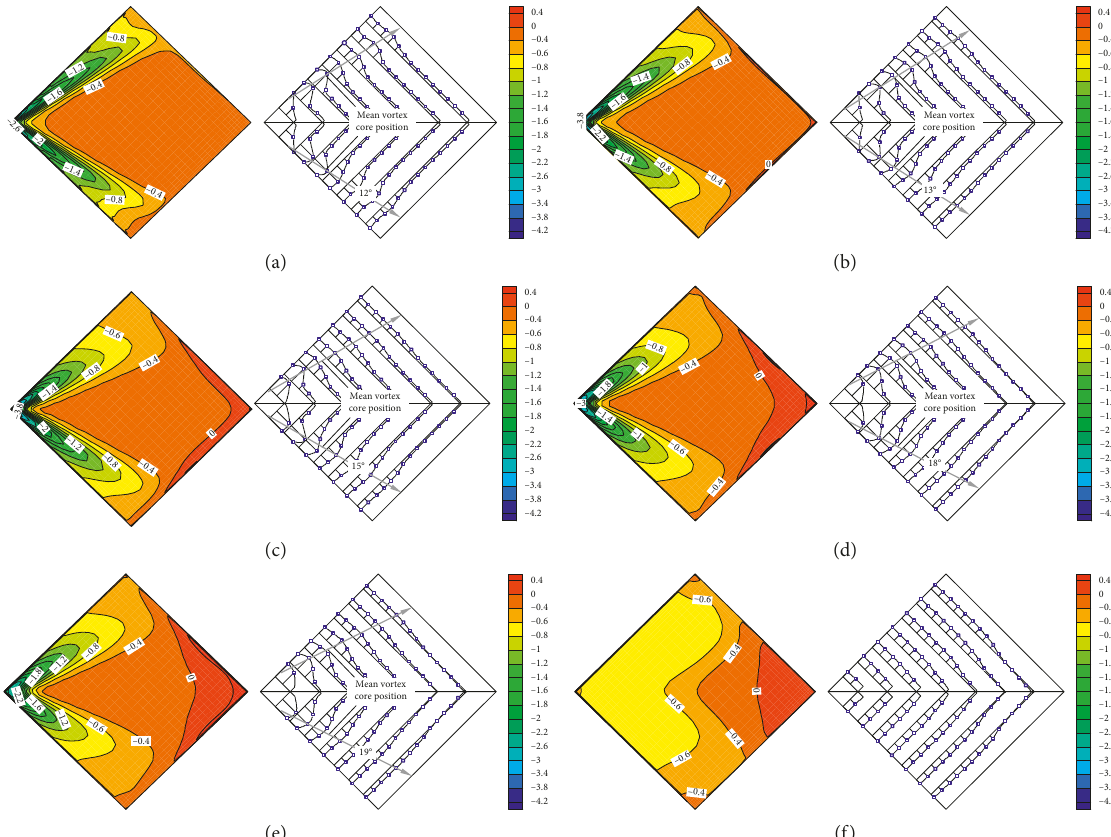
Figure 9: Contours of mean pressure coefficients and mean suction profiles on flat roofs with different relative parapet heights. (a) h no parapet. (b) h p / H